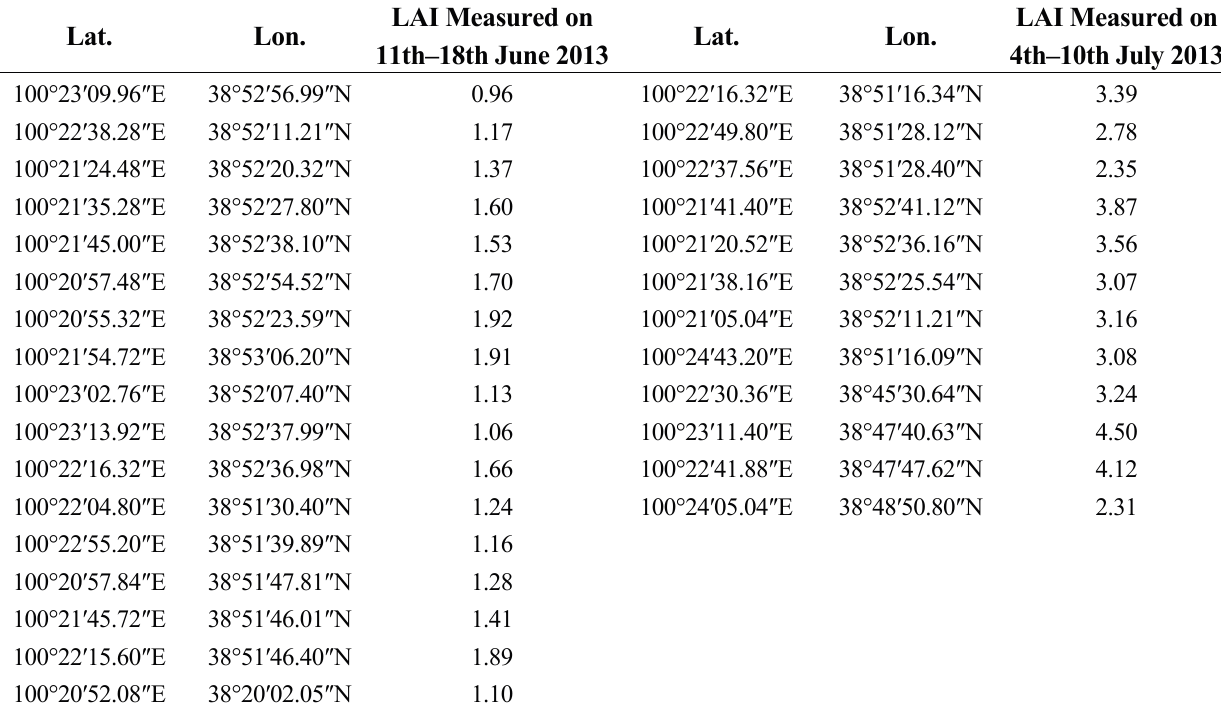
Table 3. Description of LAI field measurements obtained from 11 to 18 June and to 10 July 2013. Lat.